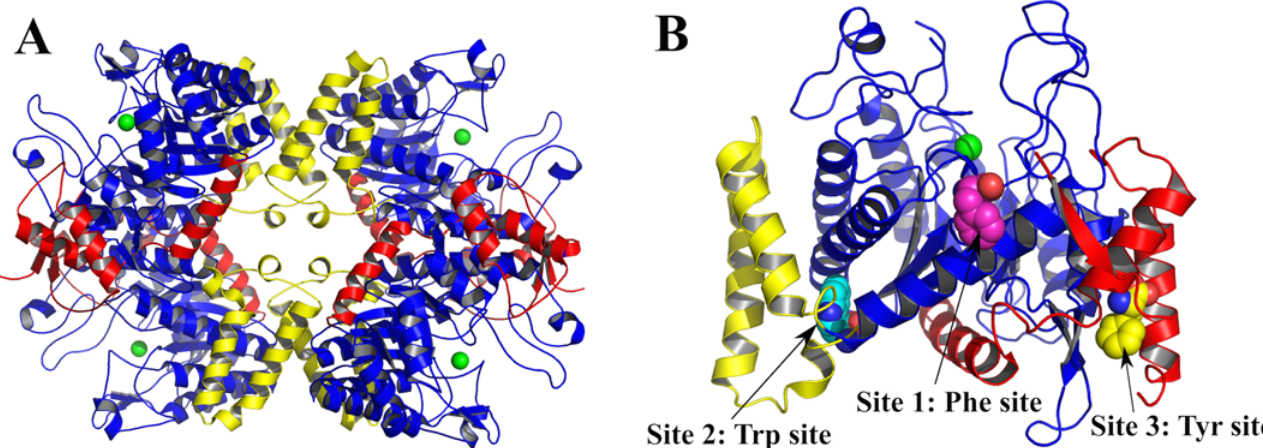
Fig 1. Structure of M . tuberculosis DAH7PS. (A) Mtu DAH7PS tetramer (PDB code 3NV8), the N-terminal extension (red) and α 2 β 3- insertion (yellow) play key roles in the quaternary structure assembly. The core barrel residues are shown in blue, the active site metal ion is shown as a green sphere. (B) Allosteric binding sites of Mtu DAH7PS (PDB code 3KGF): in this structure, Phe occupies site 1 (purple spheres) and site 3 (yellow spheres). Trp occupies site 2 (cyan spheres).